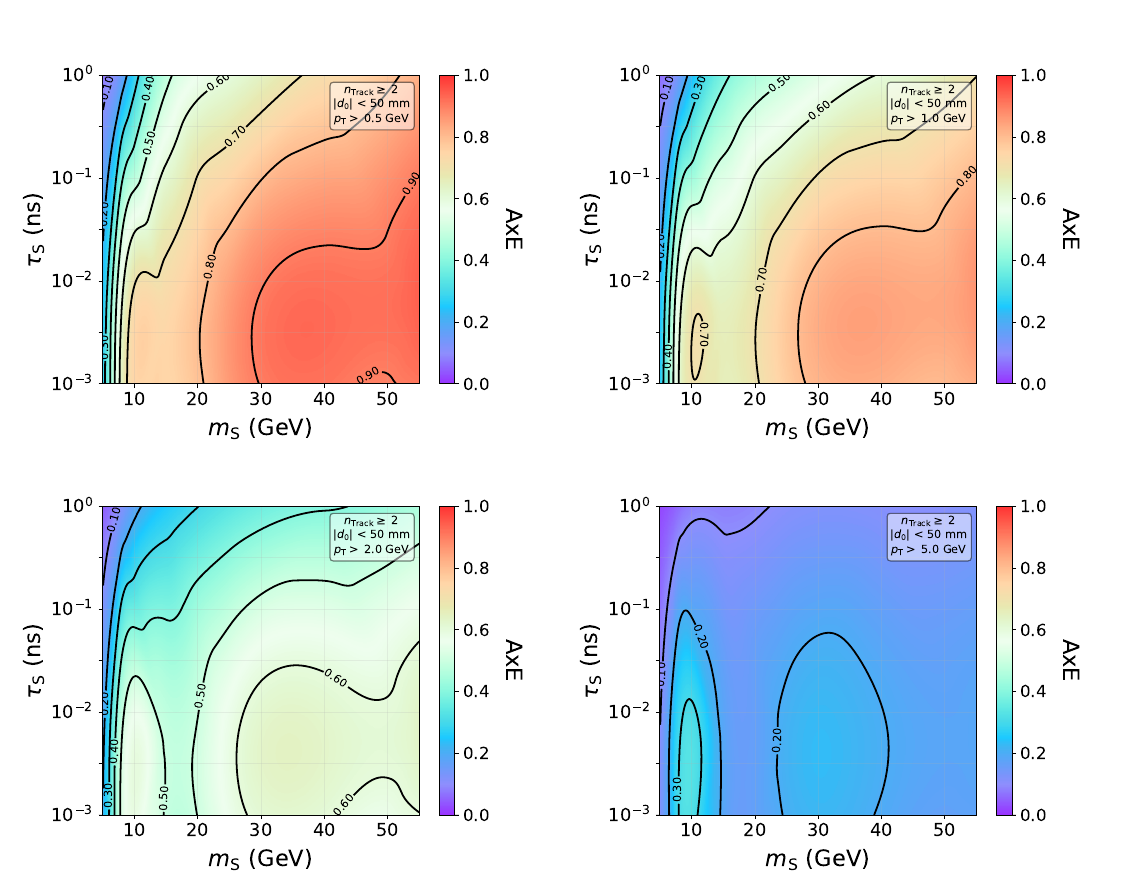
Figure 31. Event-level acceptance times efficiency for Higgs portal model with a constant | d 0 | endpoint and p thresholds ranging (clockwise from top left to bottom left) from 0.5 Gev, 1.0 GeV, T 2.0 Gev, and 5.0 GeV. In all cases, the two-track selection and a linearly decreasing efficiency is